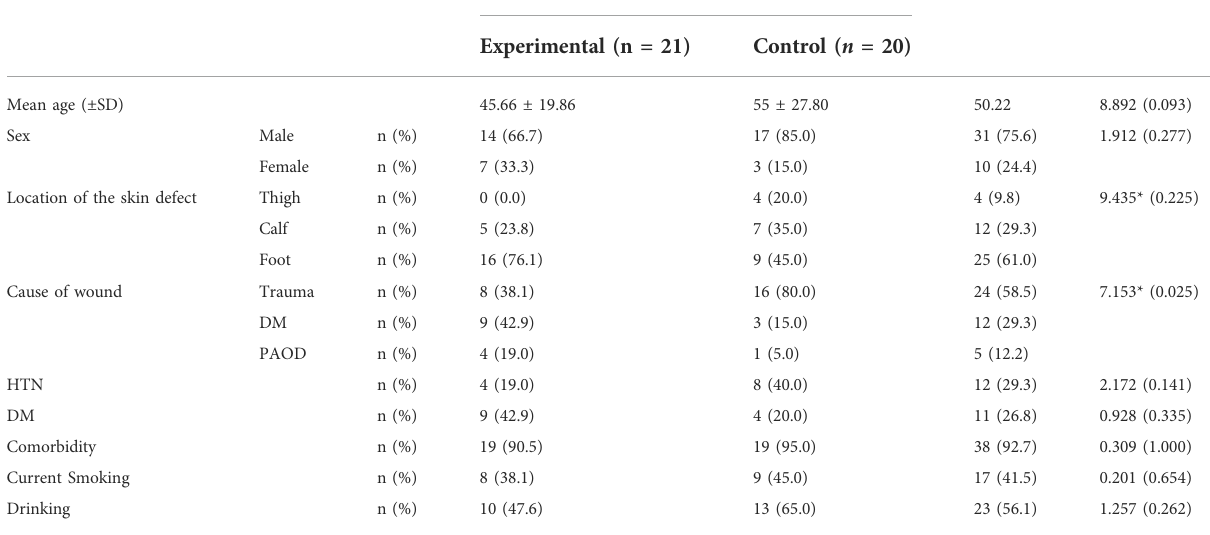
TABLE 1 Demographics of the pure-grind ADM and control